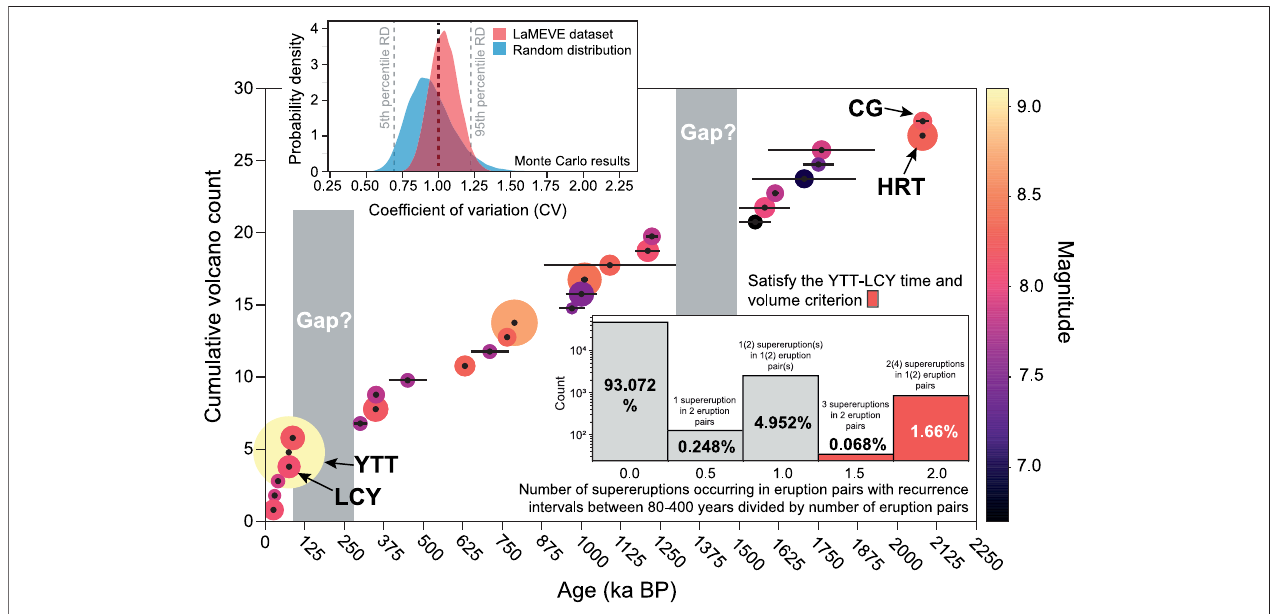
FIGURE2| Cumulativenumberoferuptions( > 400 km 3 bulktephravolume)throughthelast ca .2.2Myr(LaMEVE).Thecolorandsizeofthesymbolsrepresentthe magnitudeoftheeruptions.Blackbarsthroughsymbolsare1 σ ageuncertainties.Theupperinsetplotshowstheprobabilitydensitycurvesforthecoef fi cientofvariation (CV). Values of CV > 1 indicate clustering of eruptions and CV < 1 periodic eruptions. The lower inset histogram shows the number of eruption histories (among 50,000 synthetic eruptions histories assuming that eruptions are randomly distributed) that contain paired eruptions within 80 – 400 years and at least one